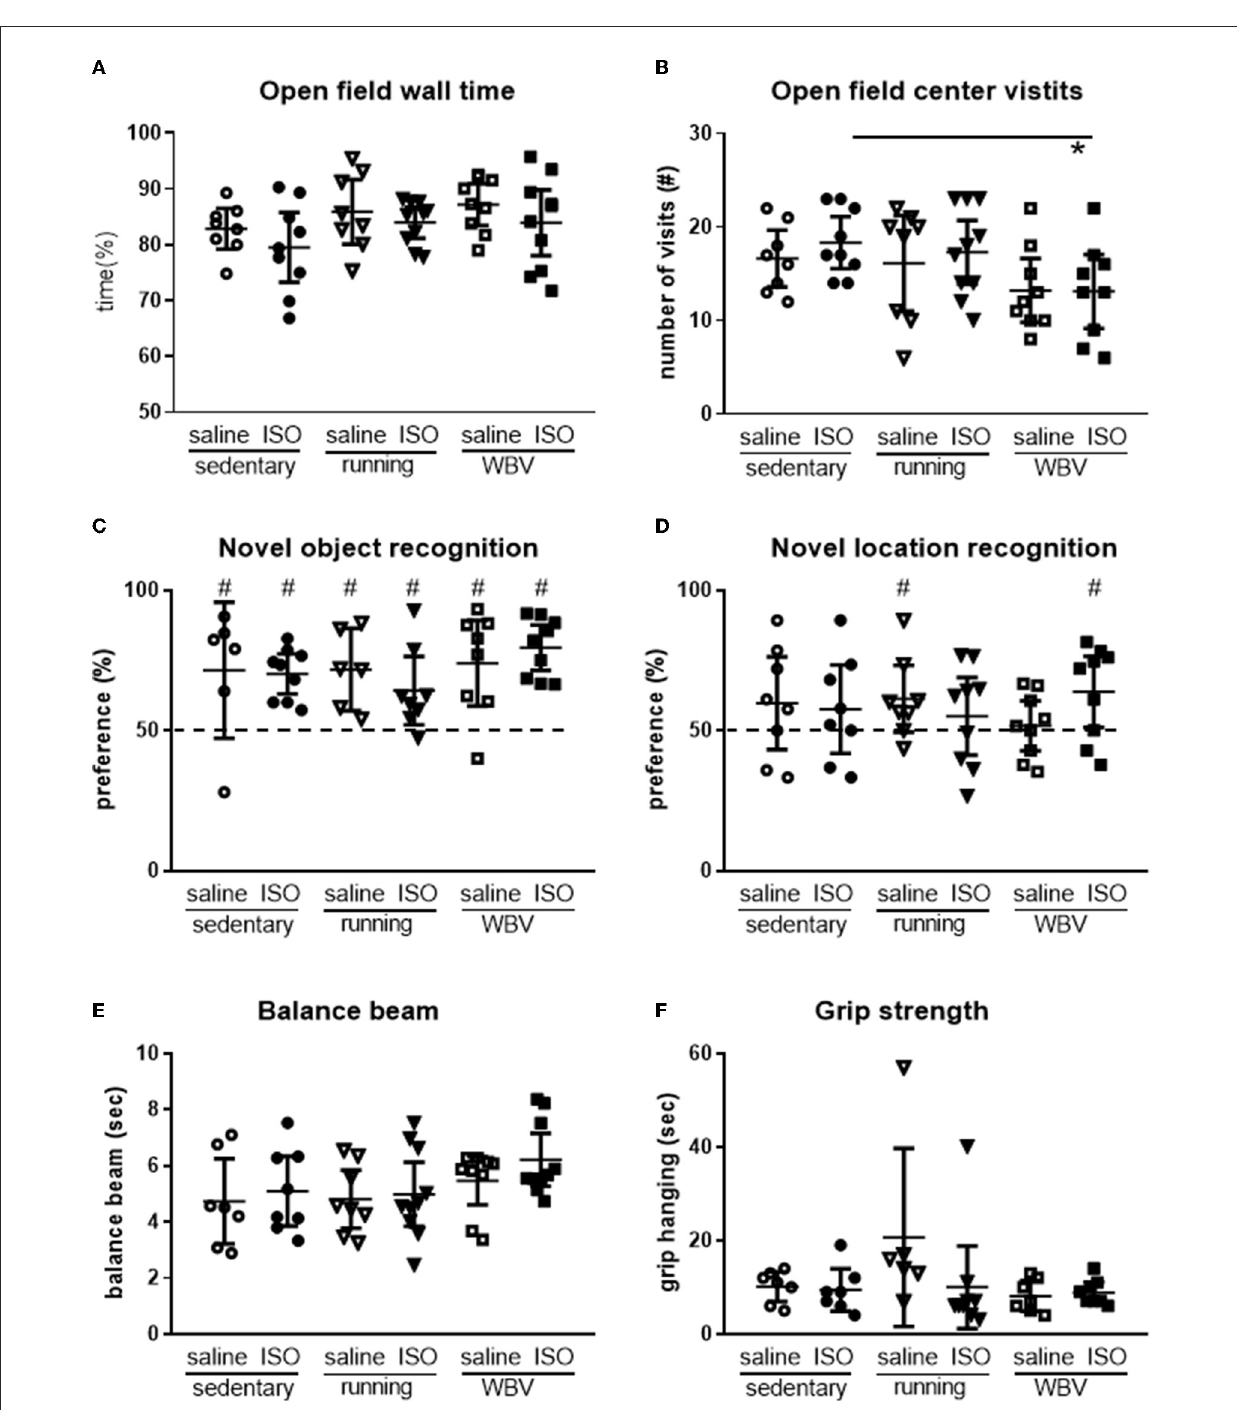
FIGURE8 Exploration in the open field ( n = 8–10 per group) was measured as time spent along the wall (A) and the number of center visits (B) , cognitive performance measured in the novel object- [ (C) ; n = 6–10 per group] and the novel location recognition [ (D) ; n = 8–10 per group] tests, and motor performance measured by the time rats needed to cross the balance beam [ (E) ; n = 7–10 per group] and the time they could keep their grip on the hanging bar ( F ; n = 6–9 per group) in saline- or isoproterenol (ISO)-treated rats, under sedentary conditions, or after 5 weeks of exercise training (running) or whole-body vibration (vibration). *Significant difference between indicated groups ( p < 0.05); # significantly above chance level (dashed line = 50% = chance